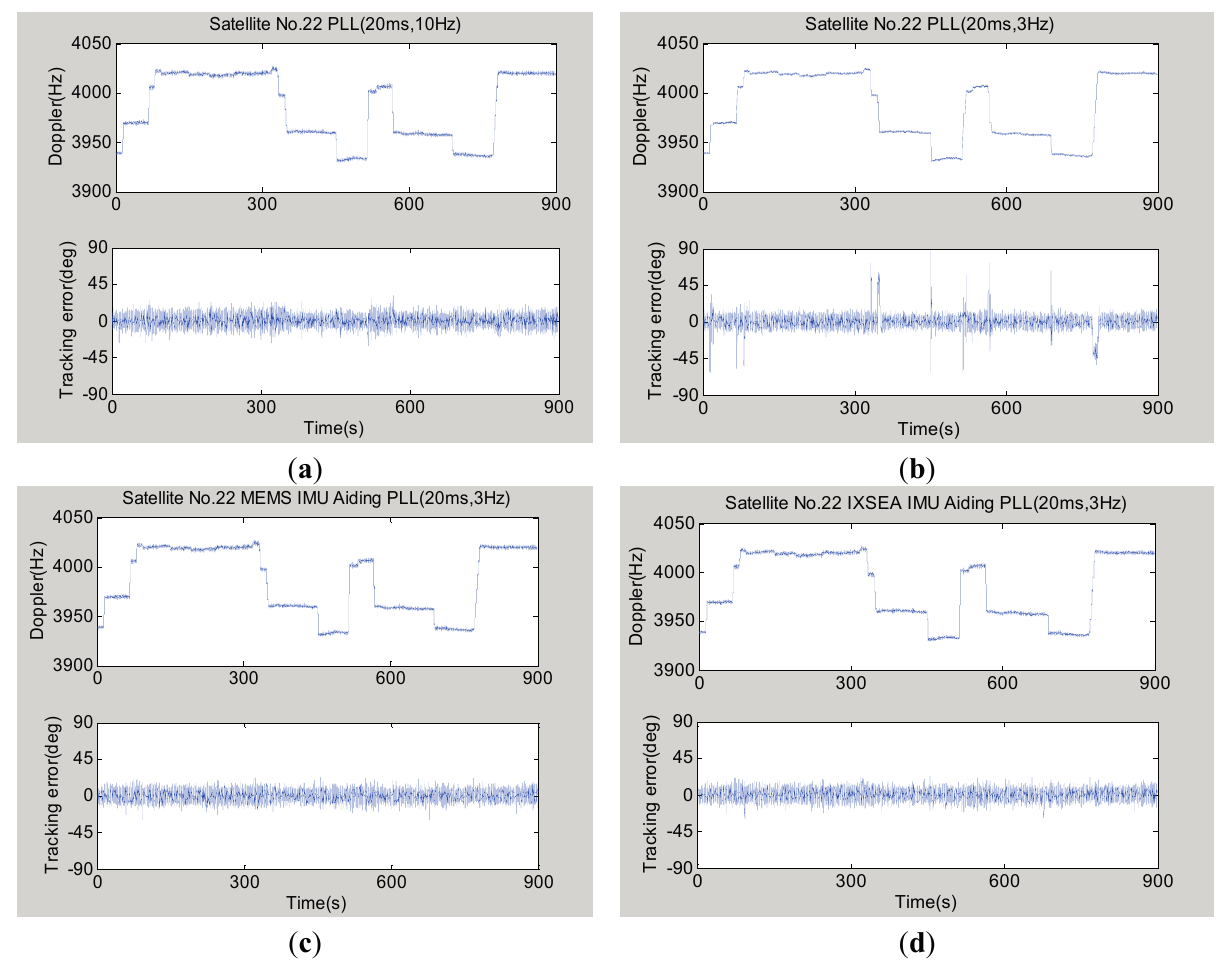
Figure 15. GNSS carrier phase tracking error in the lower dynamic scenario testing based on the simulator. ( a ) Normal PLL (20 ms, 10 Hz); ( b ) normal PLL (20 ms, 3